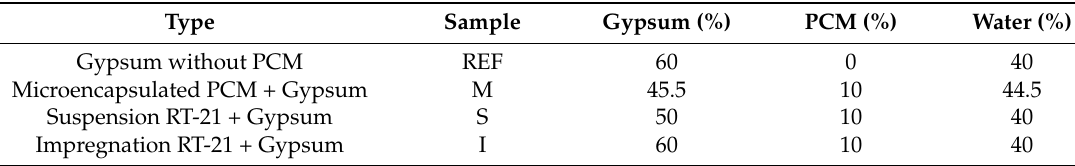
Nomenclature and sample formulations (percentages in weight).